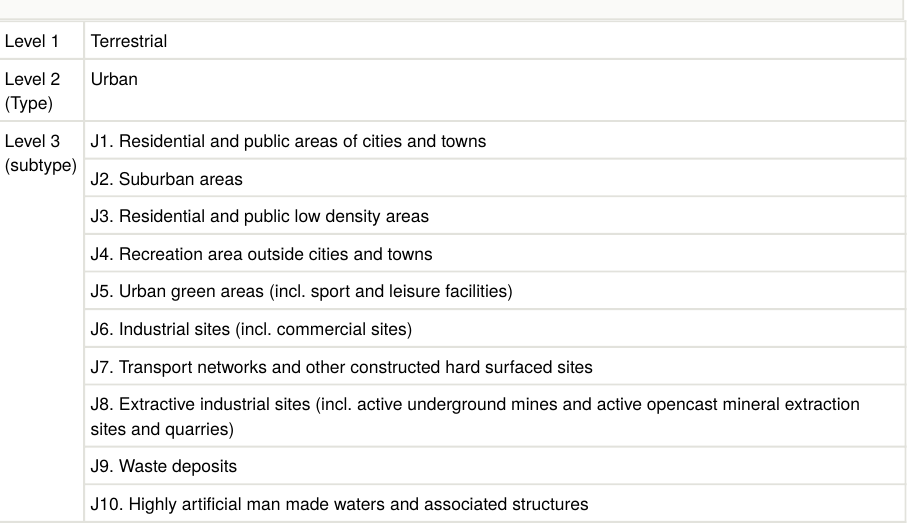
Typology of urban ecosystems in Bulgaria (Zhiyanski et al.